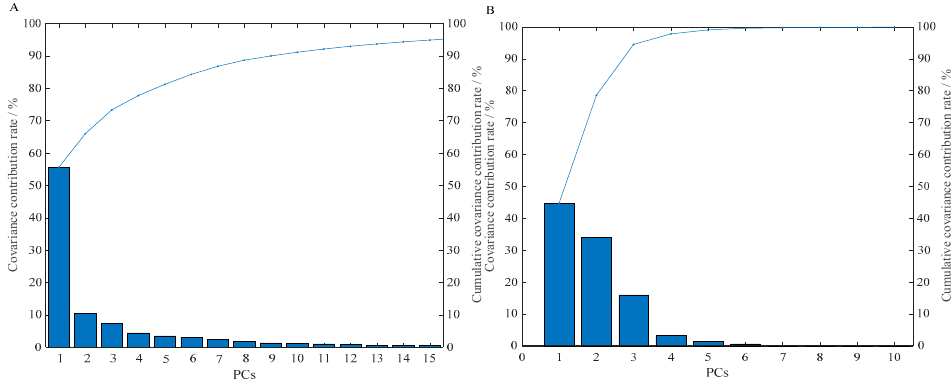
Figure 4. Statistical results of the covariance contribution rate and cumulative covariance contribution rate of the PCs with different technical data. ( A ) Olfactory visualization sensor; ( B ) NIR spectroscopy.